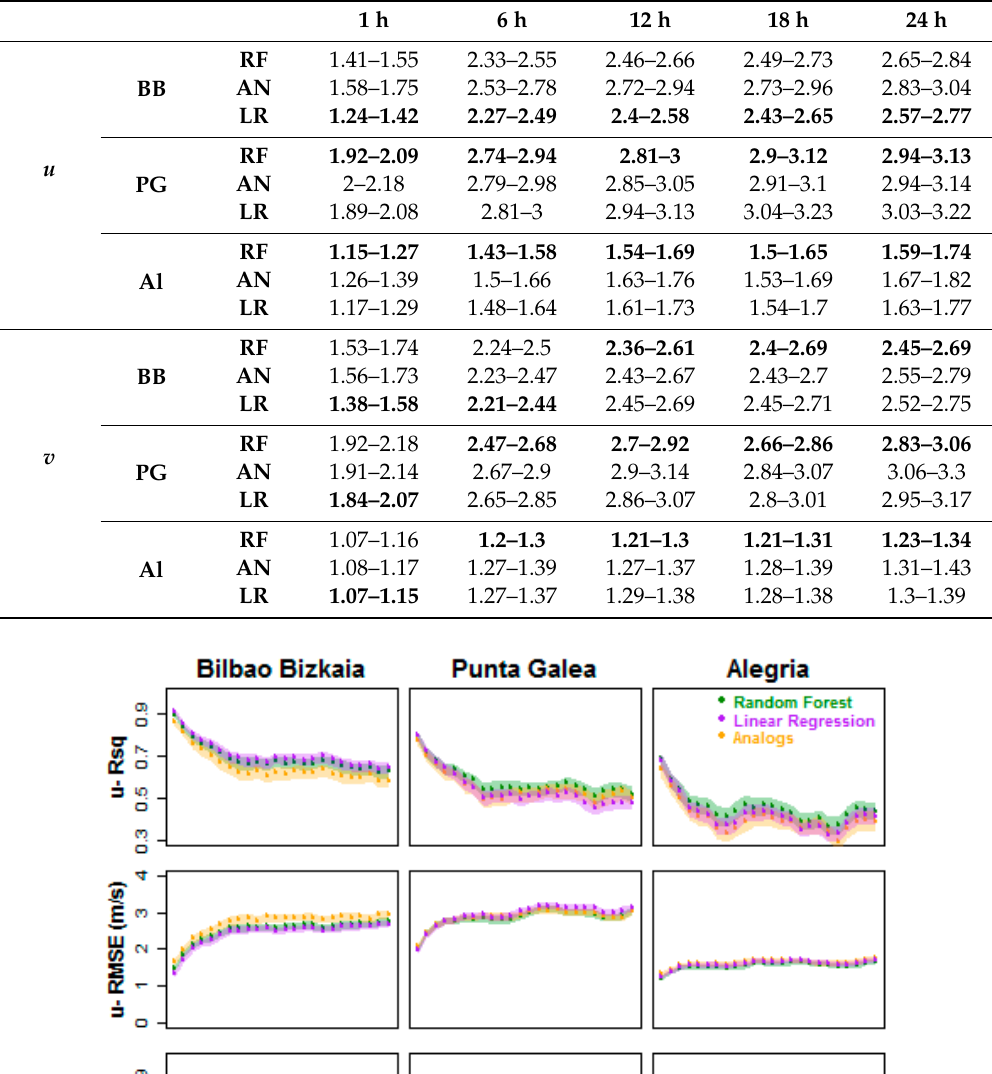
Table 4. RMSE verification index of u and v wind components for the steps 1, 6, 12, 18, and 24 h, for three locations (Bilbao Bizkaia, Punta Galea, and Alegria), and three statistical methods (random forest, analogs, and linear regression). Lowest values of RMSE are written using bold font.